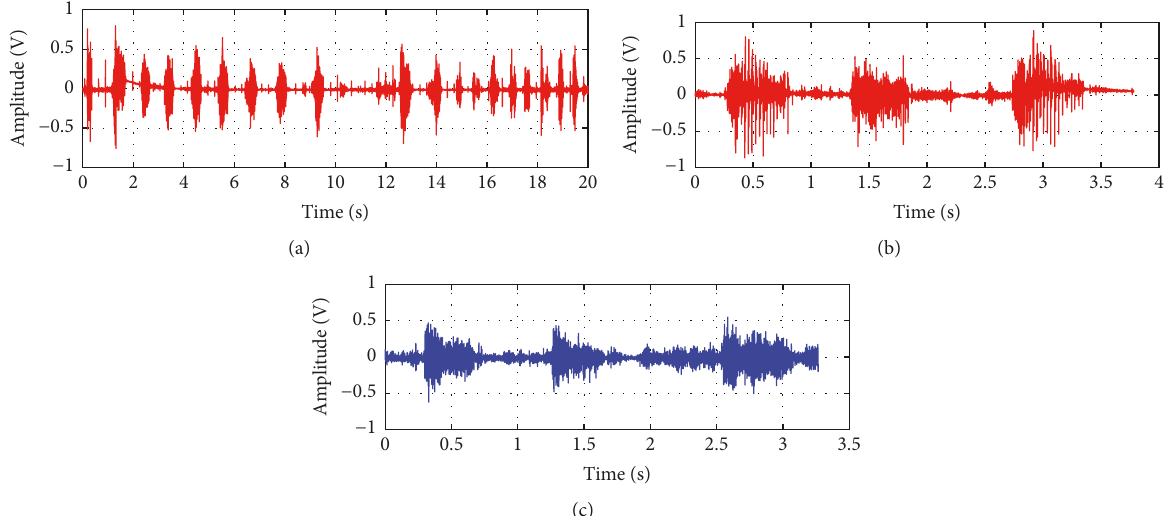
Figure 3: Typical time domain data. Representative time domain audio data showing (a) a typical pretreatment breathing gap and a comparison between pretreatment (b) and posttreatment (c).